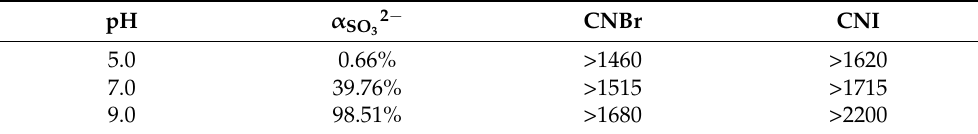
Table 4. Reaction rate constants for CNXs at different pH values in the presence of sulfite ( k s , 10 − 5 s − 1 ).